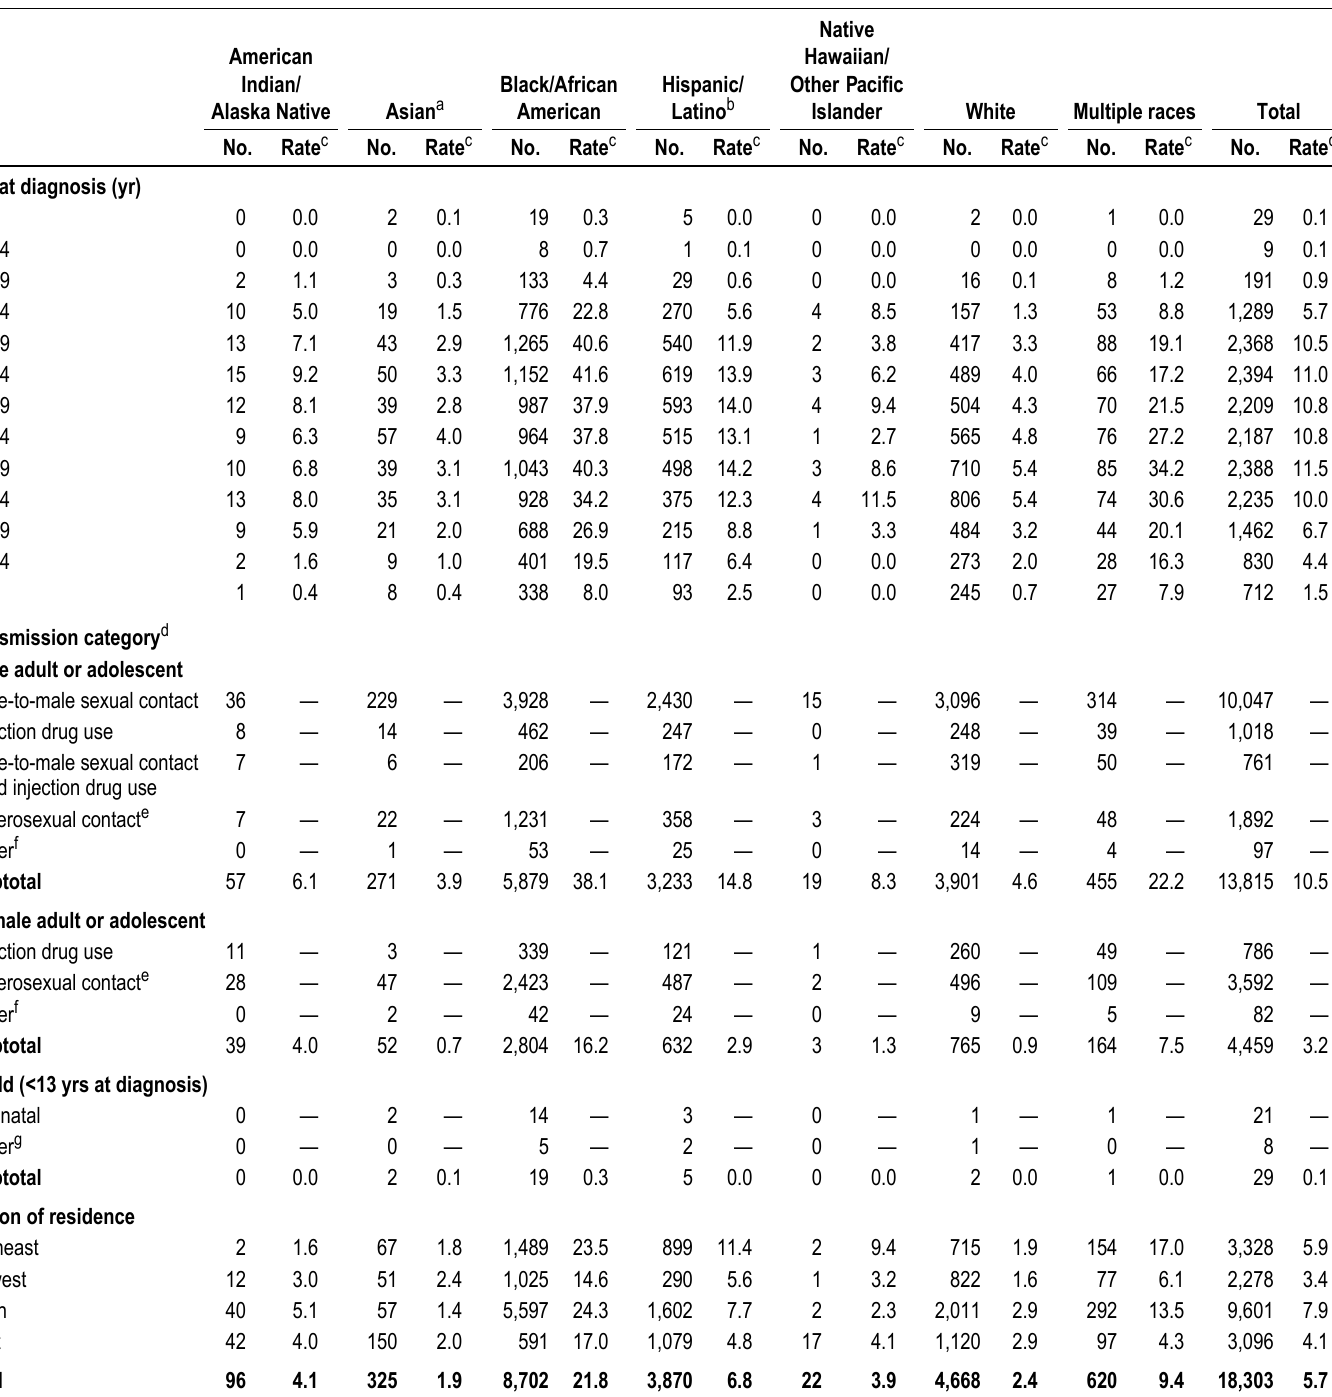
Table 4a. Stage 3 (AIDS), by race/ethnicity and selected characteristics, 2015—United